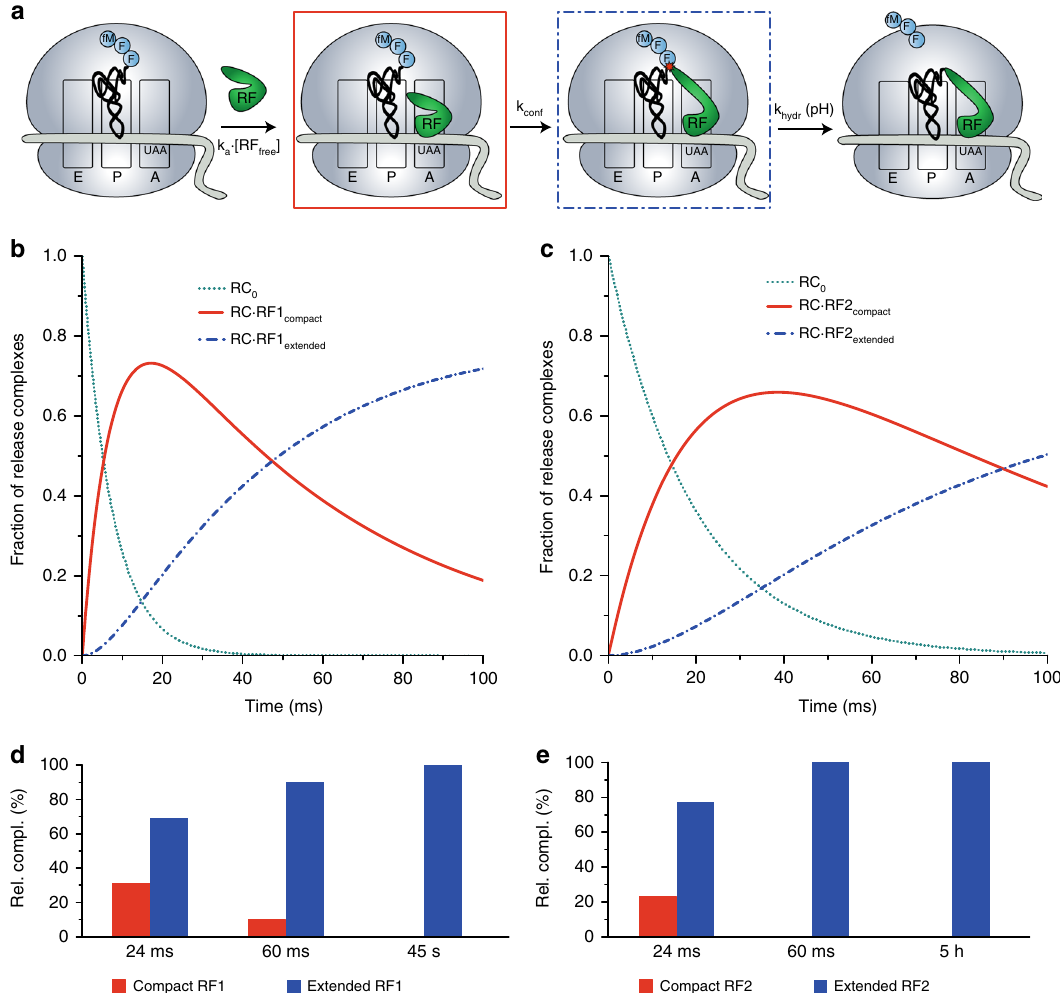
Fig. 1 Time evolution of ribosome ensembles in termination of translation a . Cartoon visualization of the pathway from free release complex to peptide release. Compact class 1 release factor (RF) binds to RF-free ribosomal release complex (RC 0 ) and forms the RC·RF compact complex with compounded rate constant k a ·[RF free ]. Stop codon recognition induces conformational change in the RF which brings the ribosome from the RC·RF compact to the RC·RF extended complex with rate constant k conf . The ester bond between the peptide and the P-site tRNA is hydrolyzed with rate constant k hydr . b Predicted dynamics of peptide release with conformational change in RF1. We solved the ordinary differential equations associated with termination according to the scheme in a with association rate constant k a = 45 µ M − 1 s − 1 , [RF1 free ] = 3 µ M, k conf = 18 s − 1 and k hydr = 2 s − 1 (Supplementary Fig. 2) and plotted the fractions of ribosomes in RC 0 , RC·RF compact and RC·RF extended forms ( y -axis) as functions of time ( x -axis). Green dot lines, RC 0 ; red solid lines, RC·RF compact ; blue dash lines, RC·RF extended . c Predicted dynamics of peptide release with conformational change in RF2. The fractions of ribosomes in different release complexes were obtained in the same way as b with the rate constants k a = 17 µ M − 1 s − 1 , [RF2 free ] = 3 µ M, k conf = 11 s − 1 and k hydr = 2.7 s − 1 (Supplementary Fig. 3). d , e The populations of release complexes containing compact conformation and extended conformation of RF1 ( d ) and RF2 ( e ) at the 24 ms, 60 ms and long incubation time points as obtained by time-resolved cryo-EM after 3D classi fi cation of the particle